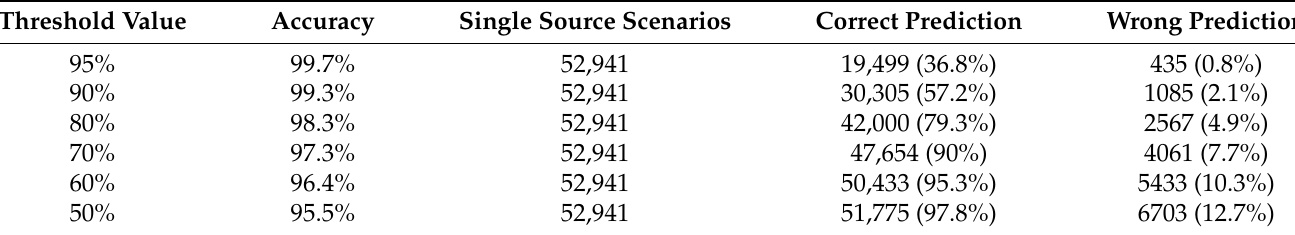
Table 4. Influence of threshold value on model accuracy for Richmond network (180 estimators, maximum depth 80, minimum samples for split 10). Percentage indicates number of predicted simulations based on total number of single source scenarios.